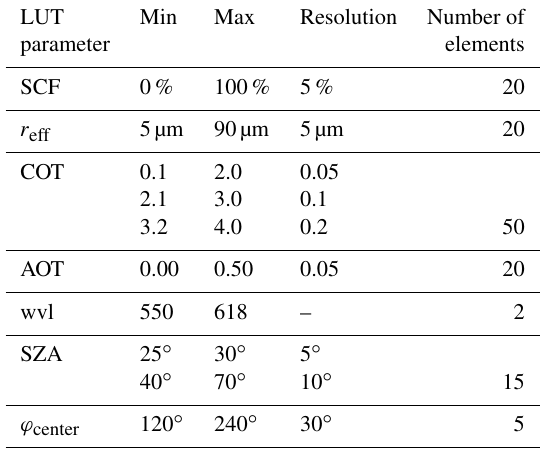
Table 2. Lookup table parameters: minimum value, maximum value, and resolution for smooth crystal fraction (SCF), effective radius ( r eff ), cirrus optical thickness (COT), aerosol optical thick- ness (AOT), wavelength (wvl), solar zenith angle (SZA), and cen- tral value of the Sun-centered azimuth angle ϕ center for each of the five image segments. COT and AOT are defined at a wavelength of 550nm. LUT Min Max Resolution Number of parameter elements SCF 0%